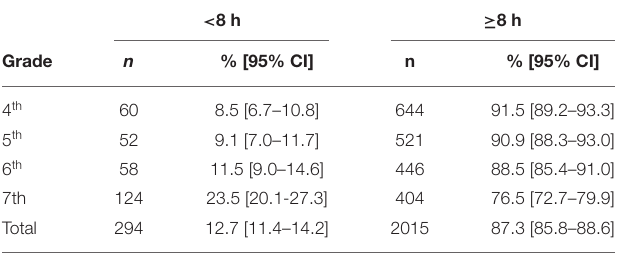
TABLE 7 | Sleep deprivation by grade ( n = 2,309; Missing data =